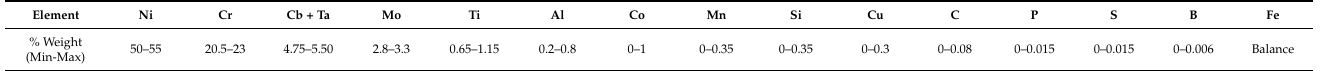
Table 1. Chemical composition of the IN718